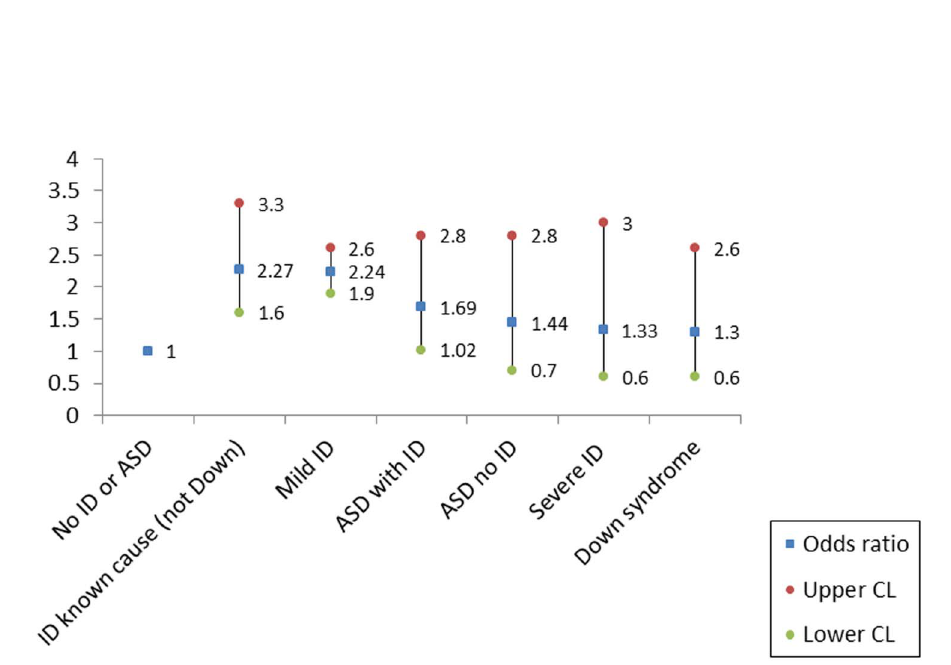
Fig. 2. Kaplan-Meier survival rates of mothers of children with no intellectual disability or ASD, mothers of children with intellectual disability and mothers of children with ASD.